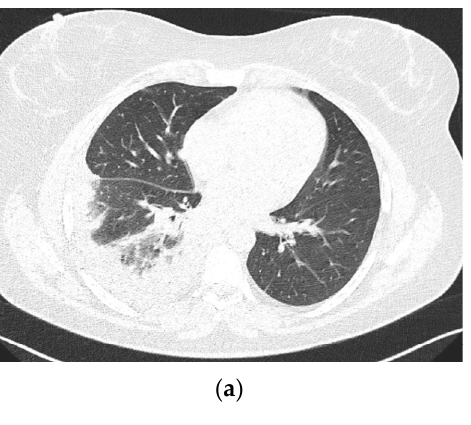
Figure 3. Thoracic CT scan images showing ( a ) pulmonary embolism, pulmonary infarction, and ( b ) secondary pleurisy. Approximately fifteen days after surgery, the patient developed right thoracic stabbing pain, fever, and chills. She was admitted to the cardiology clinic for investigations. The patient was hemodynamically stable. Pulses were present in the lower limb arteries, and the Doppler ultrasound exam found no signs of venous thrombosis. Blood tests showed leukocytosis, elevated levels of inflammatory markers, and a very high D-dimer level. Right heart cavities systolic dysfunc- tion was excluded via cardiac ultrasonography. Chest radiography revealed discrete opacities located in the right lung’s base and opacity of the costo-diaphragmatic right recess. A thoracic